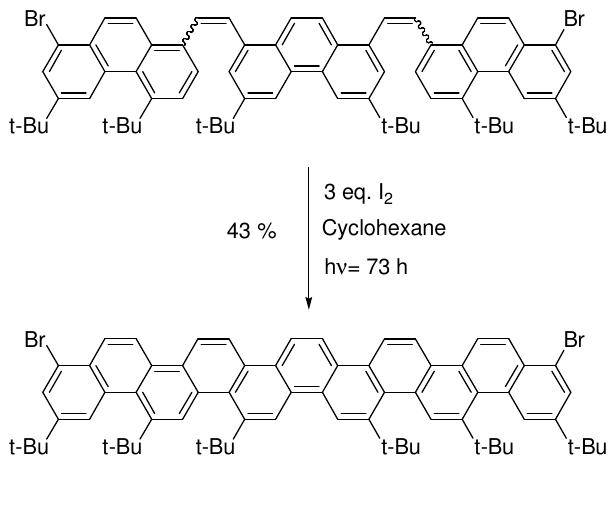
Scheme 15. Photochemical synthesis of